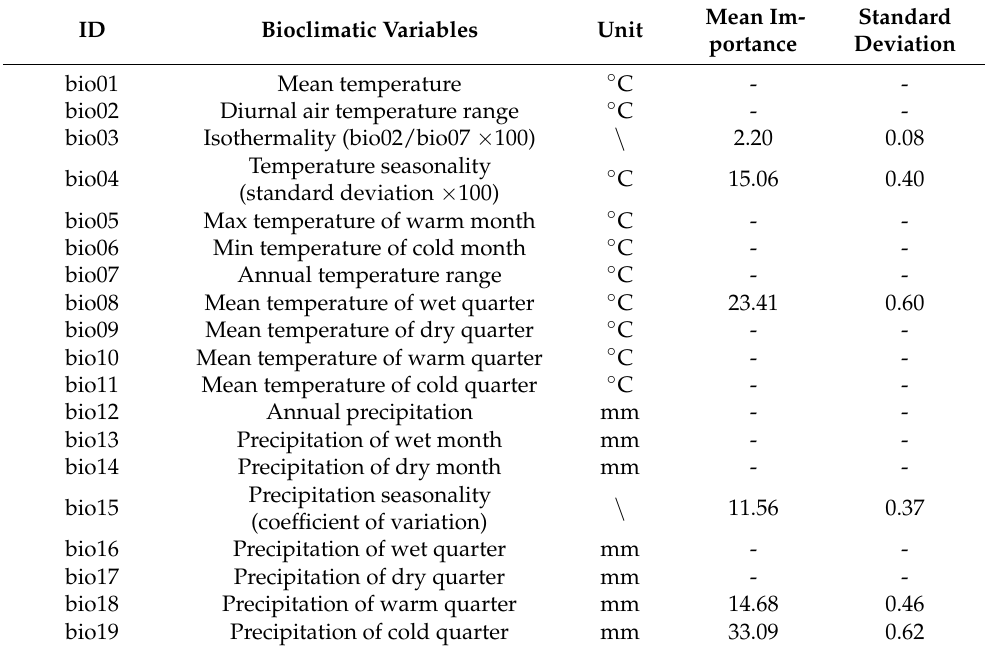
Table 1. Bioclimatic variables and importance in